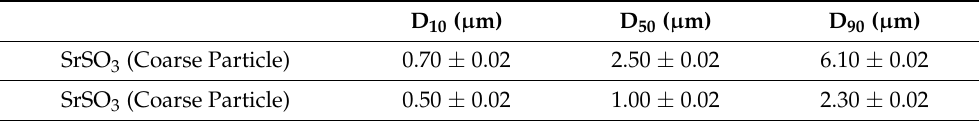
Table 1. The particle size analysis results of the two different types of raw material SrCO 3 .